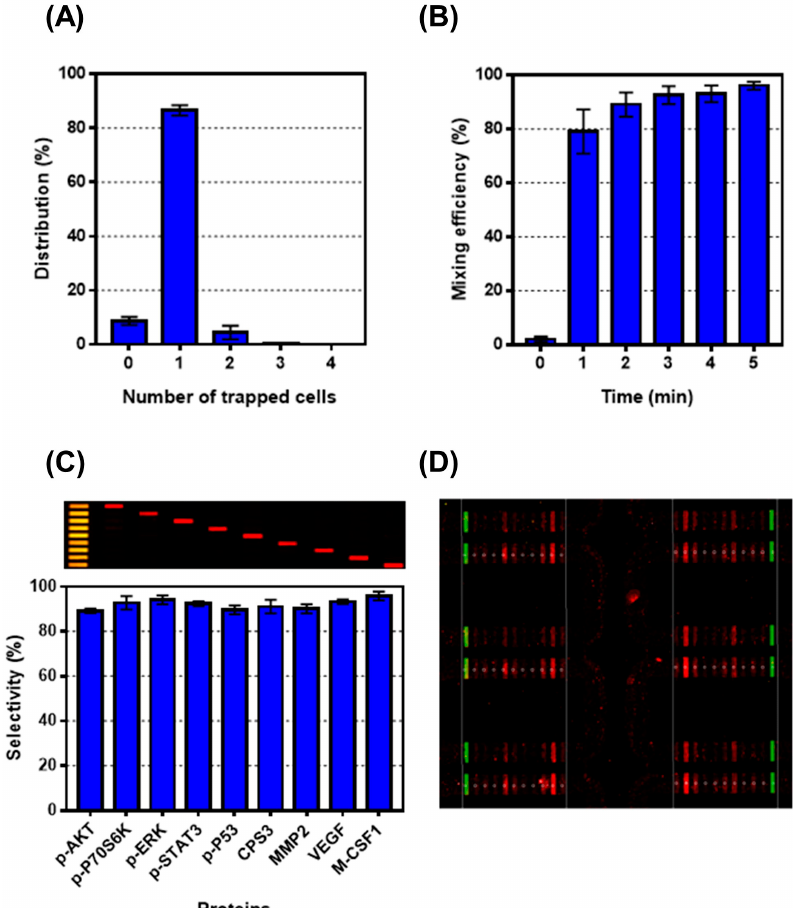
Figure 2. Validation of single-cell proteomics assay chip. ( A ) Of the 1376 chambers, 98.9% ( ± 0.15%) acquired cancer cells and 89.5% ( ± 3.7%) of the trapped cells were verified as single cells. ( B ) High (>95%, within 5 min) mixing efficiency was achieved. ( C ) Fluorescent image of a cross-reactivity result (upper) is shown, and selectivity values are shown with high selectivity (>89.5%) between the target proteins and corresponding antibody (lower). ( D ) Fluorescent image of multiplexed antibody array. The reference probes are green while the capture antibody arrays are red.